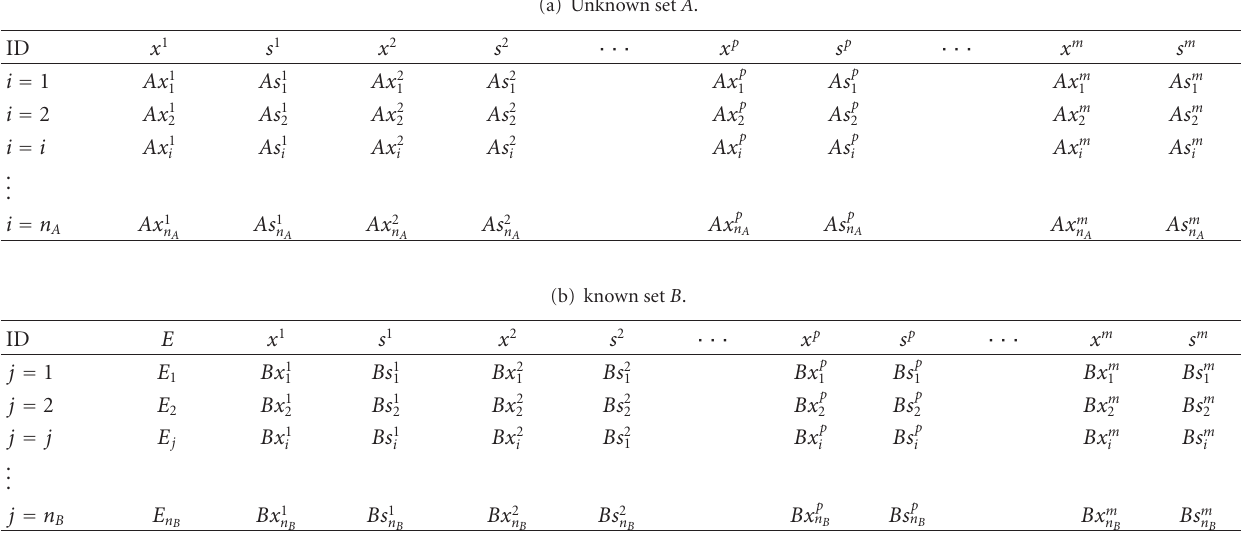
Table 1: Rank and score variables for unknown set A and known set B . It shows the rank and score variables for the unknown set A and known set B . The ID column shows the identity object. Each of which contains the scores for m variables, x 1 , x 2 , ... , x p , ... , x m , where 1 ≤ p ≤ m , and the known dataset has a validation variable E . The score values for objects i = 1,2, ... , n A in the unknown dataset A can then be denoted by AX i = { Ax 1 i , Ax 2 i , ... , Ax m i } , and the rank values can be denoted by AS i = { As 1 i , As 2 i , ... , As m i } . The score values for object j = 1,2, ... , n B in the known dataset B can then be denoted by BX j = { Bx 1 j , Bx 2 j , ... , Bx m j } , and the rank values can be denoted by